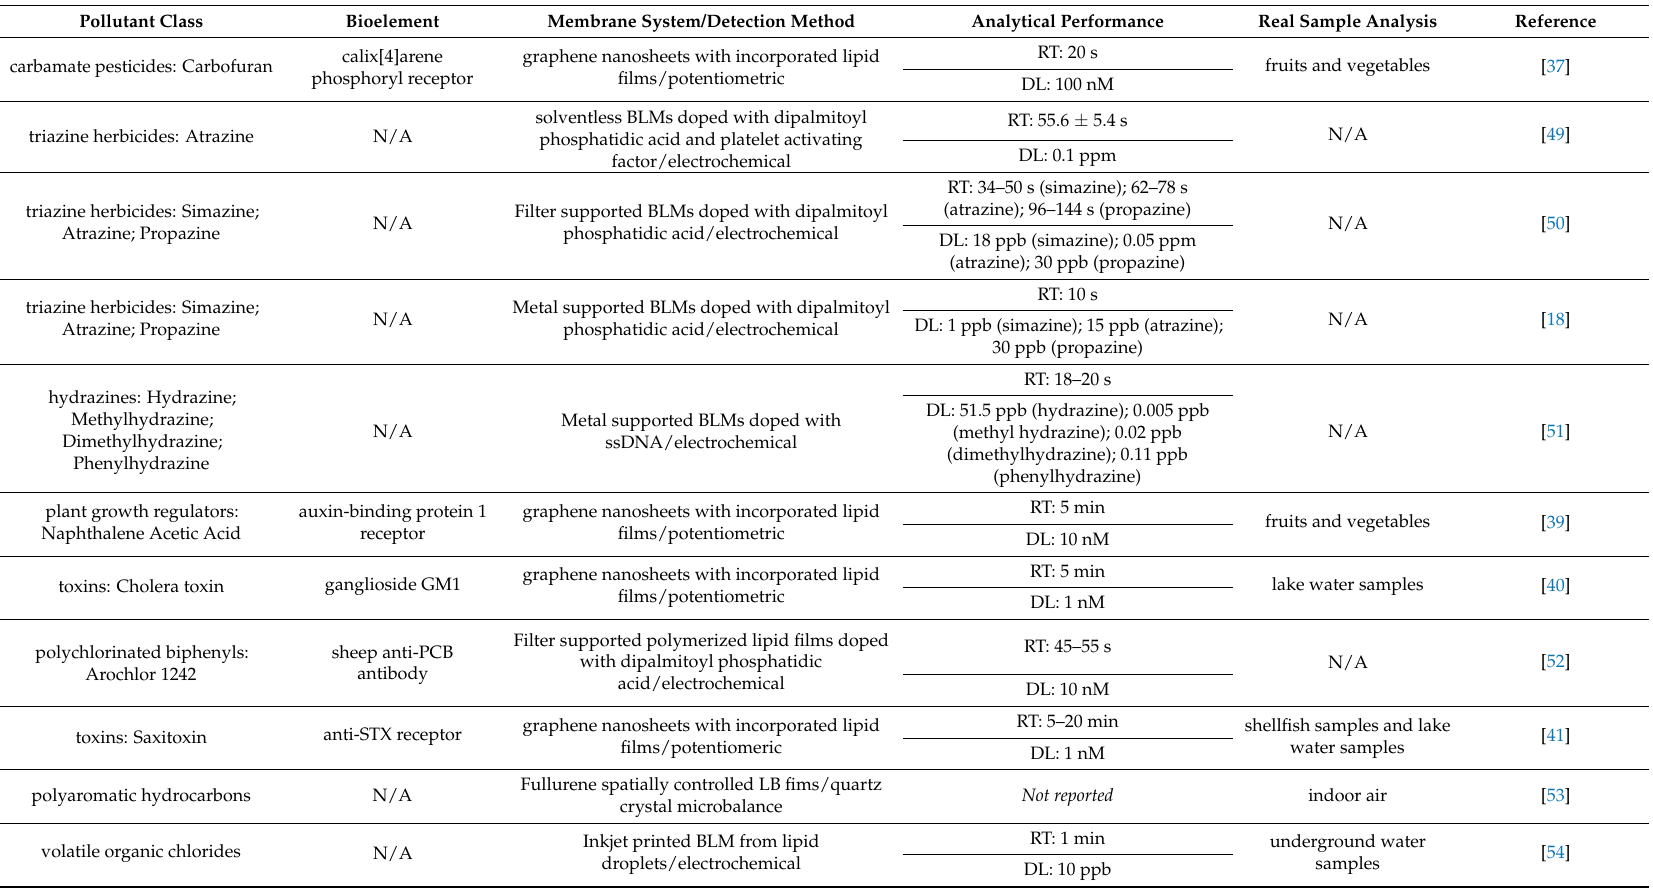
Table 1. Overview of lipid membrane nanosensors developed for environment